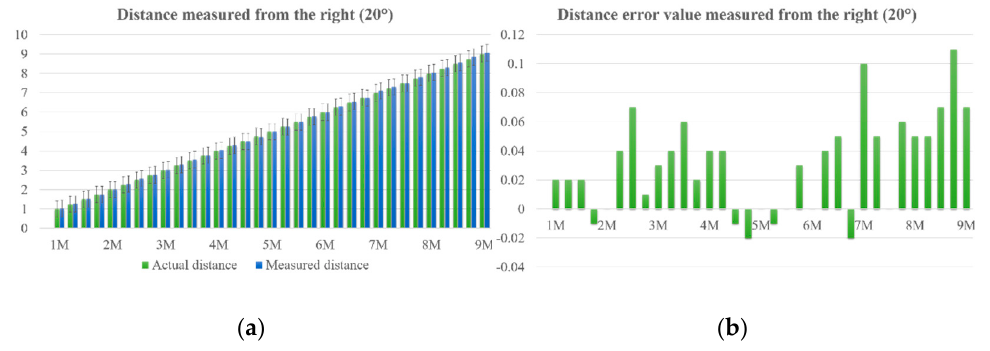
Figure 10. ( a ) Distance measured from the right (20°), ( b ) distance error value measured from the right (20°). right (20 ◦ ).